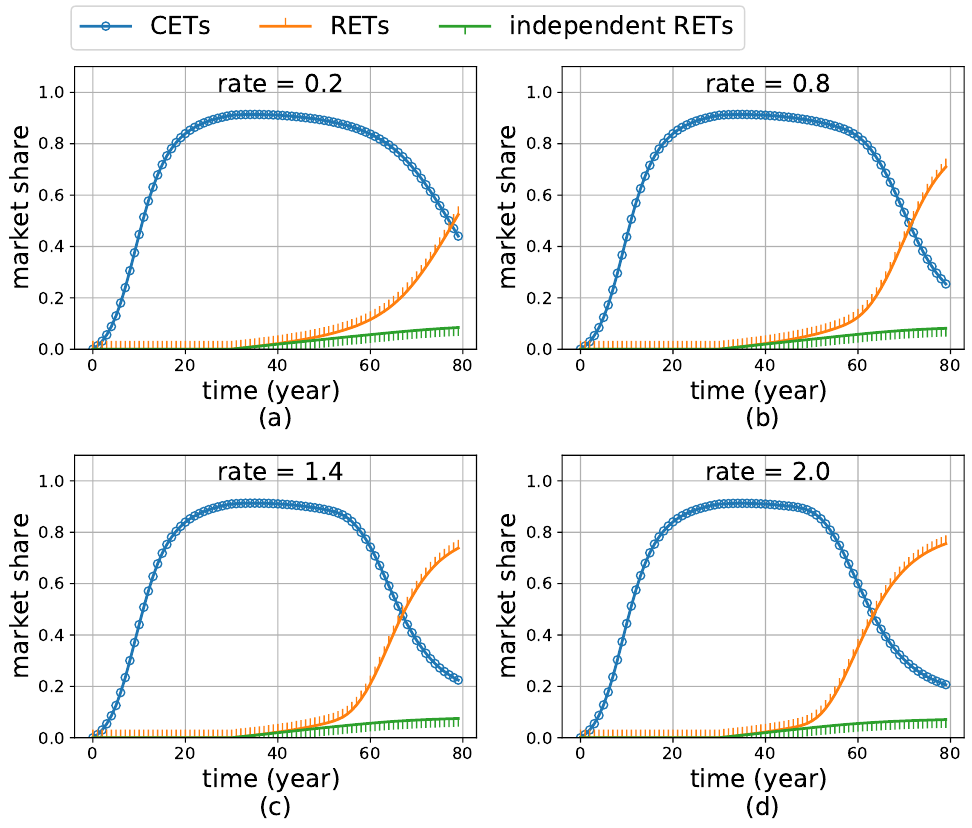
Figure 11. The impact of the RET improvement